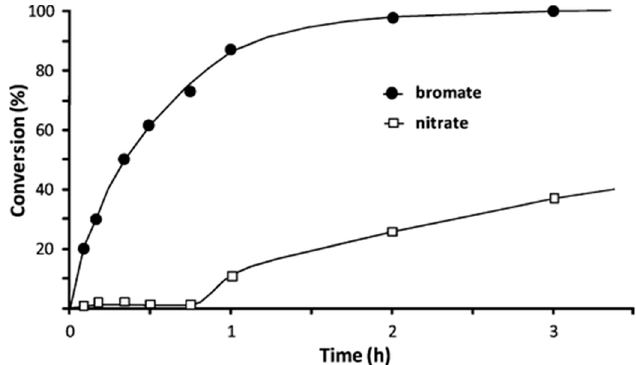
Figure 4. Simultaneous removal of bromate and nitrate ions over the (Pd/Sn-0.3/0.15)/5%carbon nanofibers grown on sintered metal fibers catalyst ([BrO 3– ] = 50 mg/L; [NO 3– ] = 100 mg/L; mcat = 2.5 g; T = 25 °C). Reprinted with permission from [70], Copyright (2013) American Chemical Society.